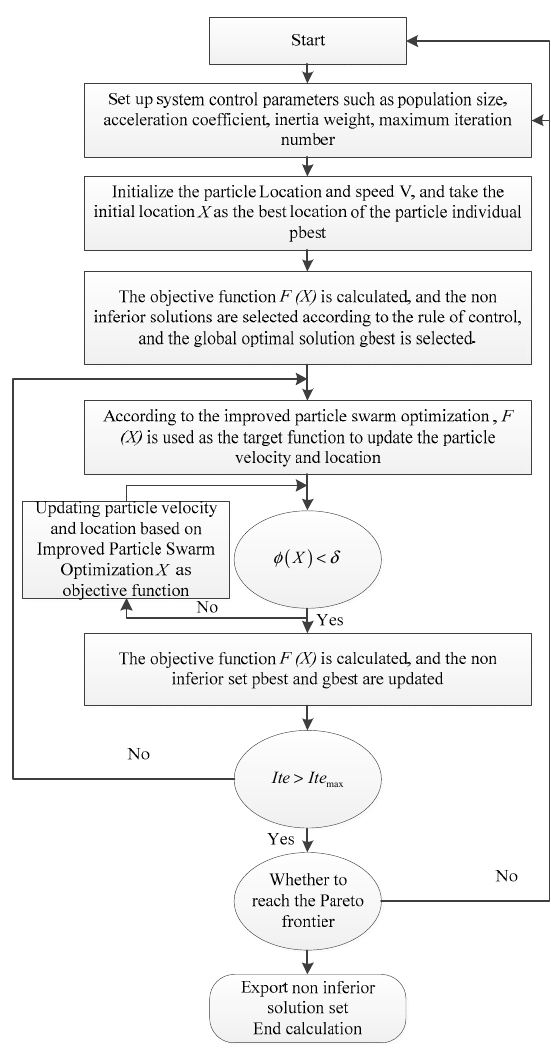
Figure 2. Flowchart of improved particle swarm optimization based on dynamic object method (DOM) constraint mechanism.